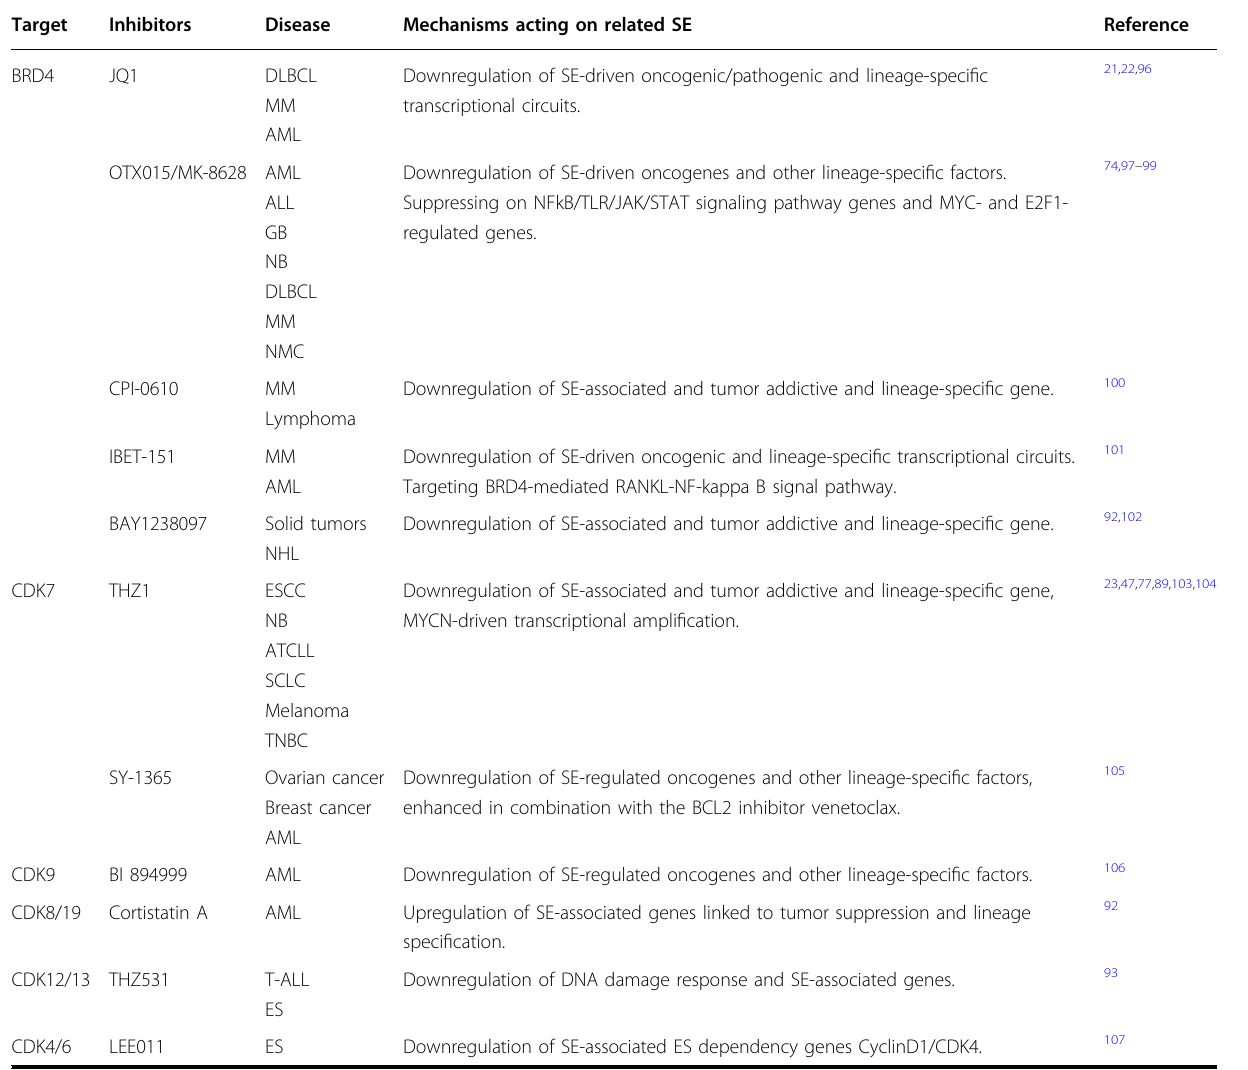
Table 1 Small molecule inhibitors targeting SE-driven transcription in tumors.